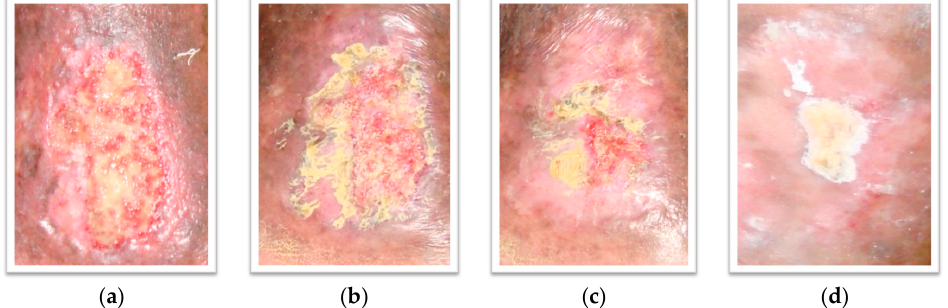
Figure 2. Photographs of the patient’s wound. PGMF: Punica granatum magistral formulation; ( a ): 1 day before PGMF treatment; ( b ): week 1 of PGMF treatment; ( c ): week 6 of PGMF treatment; ( d ): week 10 of PGMF treatment.